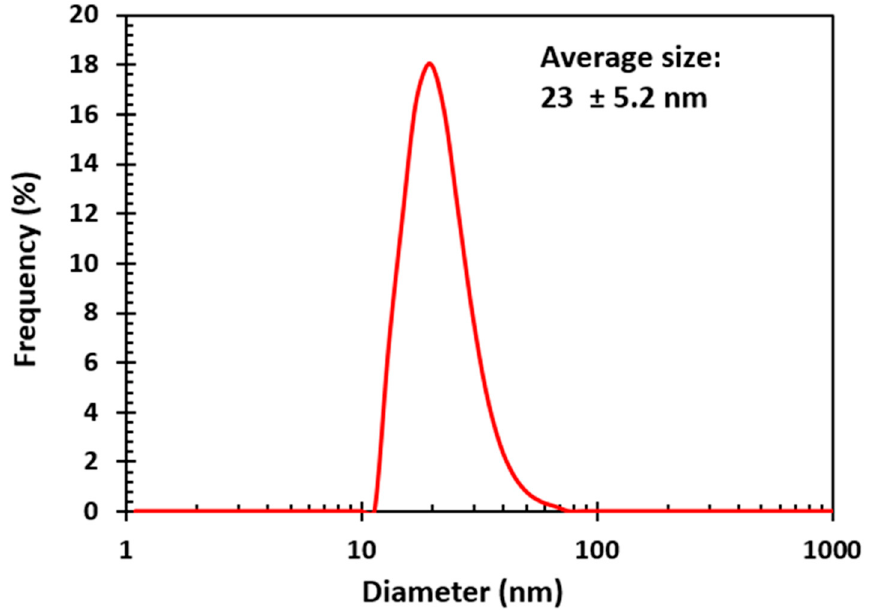
Figure 2. Dynamic light scattering measurement of synthesized silver nanoparticles.